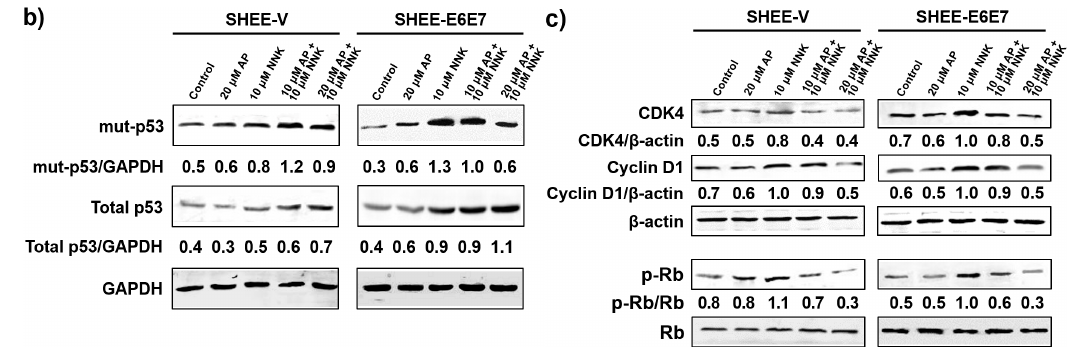
Figure 2. AP prevented cell cycle progression of SHEE cells promoted by the synergism of NNK and HPV and decreased protein expression involved in cell cycle regulation. ( a ) cell cycle distribution of SHEE cells; ( b ) total p53 and mutp53 expressions in SHEE; ( c ) expressions of CDK4, cyclin D1, and p-Rb in SHEE.